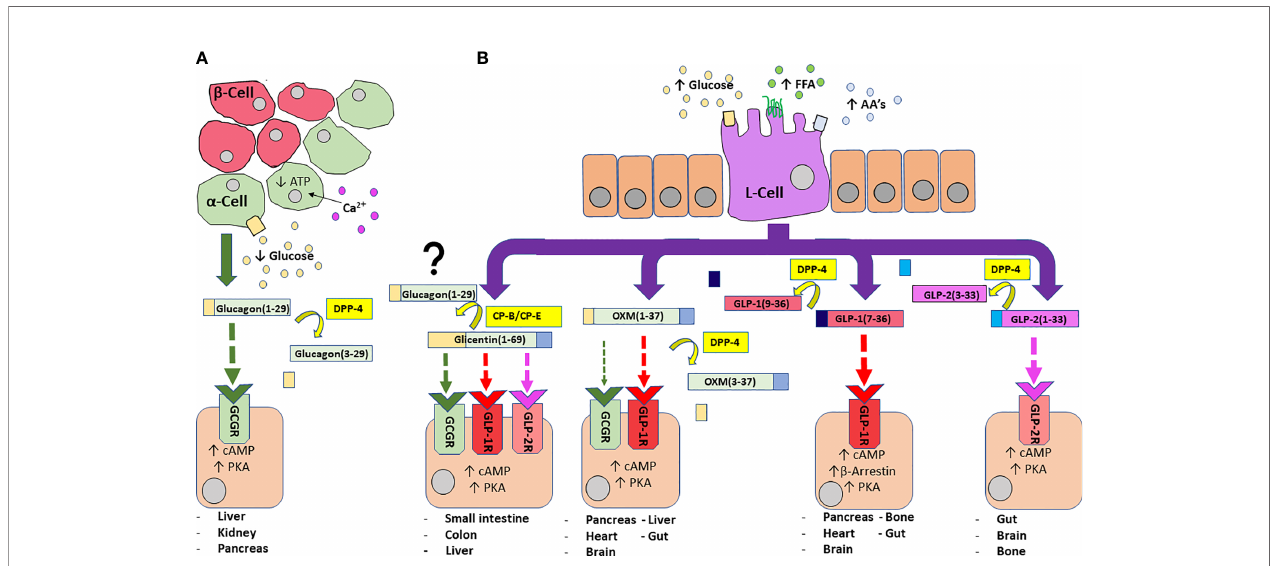
FIGURE 2 | An overview of PGDP actions and secretion from pancreatic alpha-cells (A) and enteroendocrine L-cells (B) ). A fall in circulating glucose concentration sees a reduction in intracellular adenosine triphosphate (ATP) levels and resultant closure of ATP-sensitive K + channels to depolarise the plasma membrane and trigger the in fl ux of Ca 2+ ions, the primary stimulus for glucagon release (A) . Glucagon is subject to N-terminal dipeptide removal by dipeptidyl-peptidase 4 (DPP-4). Glucagon(1-29) agonises glucagon receptors (GCGR) to evoke protein kinase A (PKA) activation and subsequent mobilisation of cyclic adenosine monophosphate (cAMP). Enteroendocrine L-cells of the distal gut are an open-type cell, rich in chemoreceptors and respond to digestion products of dietary carbohydrate, free fatty acids (FFA) and amino acids (AA ’ s) to release a number of PGDP ’ s into circulation (B) . Glicentin(1-69) is an agonist for GCGR, GLP-1R and GLP-2R, although with less af fi nity than their primary hormonal ligands. Additionally, glicentin may serve as a precursor to glucagon in the gut, facilitated enzymatic degradation by enzymes such as carboxypeptidases-B and -E (CP-B, CP-E). Oxyntomodulin (OXM) is a dual agonist for GCGR and GLP-1R, but shows bias towards GLP-1R. It is cleaved by DPP-4 to yield inactive OXM(3-37). Bioactive glucagon-like peptide 1 (GLP-1(7-36)) agonises target GLP-1R to evoke PKA-mediated rises in cAMP, while activation of b -arrestin is also implicated in insulin secretion. DPP-4 cleaved GLP-1(9-36) is inactive. Glucagon-like peptide 2 (GLP-2) agonises target GLP-2R to evoke rises in PKA/cAMP. It is inactivated by DPP-4 to generate GLP-2(3-23). Enzymes are indicated by yellow boxes/arrows. Receptor interactions are indicated by dashed lines, with af fi nity indicated by increasing thickness of the arrow. Major tissues expressing receptors are also provided.